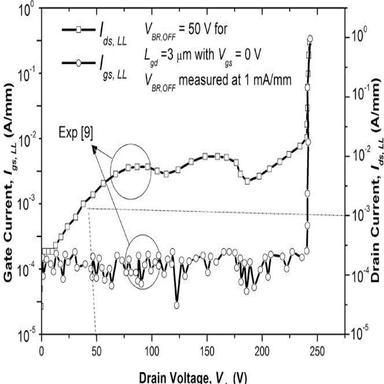
Showing the VBR,OFF characteristics in log scale with LGFP in μm and gate to drain (Lgd) of 3 μm for Al0.42ln0.03Ga0.55N(5 nm)/UID-AIN(10 nm) MIS-HEMT (Experimental) observed at the drain current (Ids) of 1 mA/mm and gate voltage (Vgs) of 0 V. Solid line (Experimental) and Symbol (TCAD simulation validation).